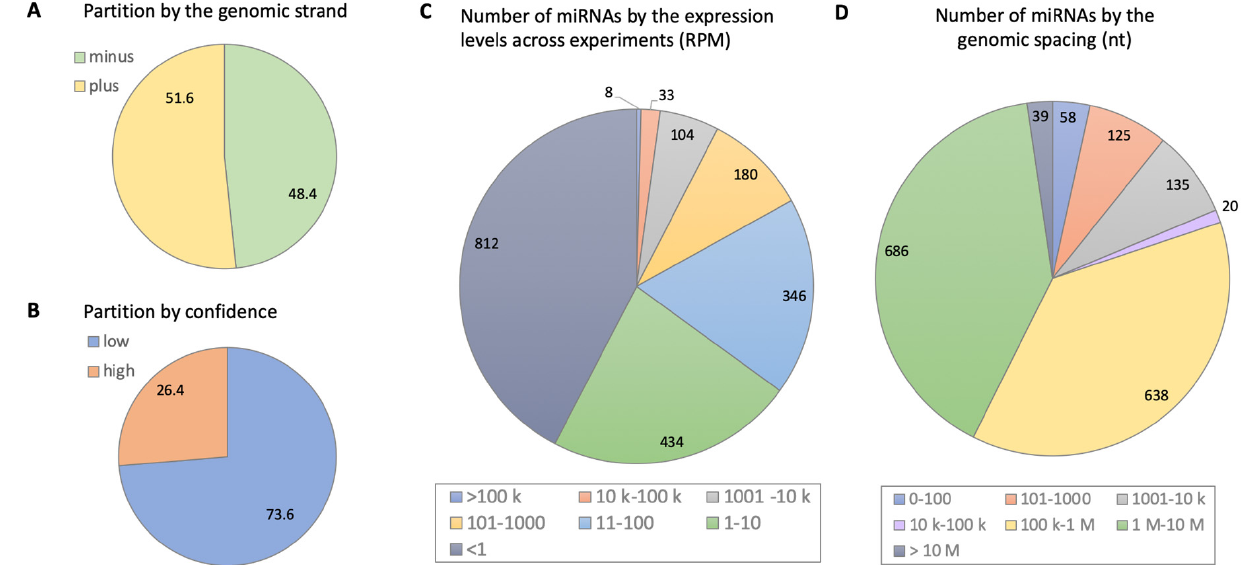
Figure 1. Summary statistics of human miRNAs according to data compiled in miRBase: ( A ) miRNA gene position by DNA strand. ( B ) Confidence level according to availability of experimental evidence. ( C ) Normalized levels of expression measured by reads per million (RPM) across the experiments compiled in miRbase. ( D ) The spacing of miRNA by genomic vicinity, measured by nucleotides (nt).